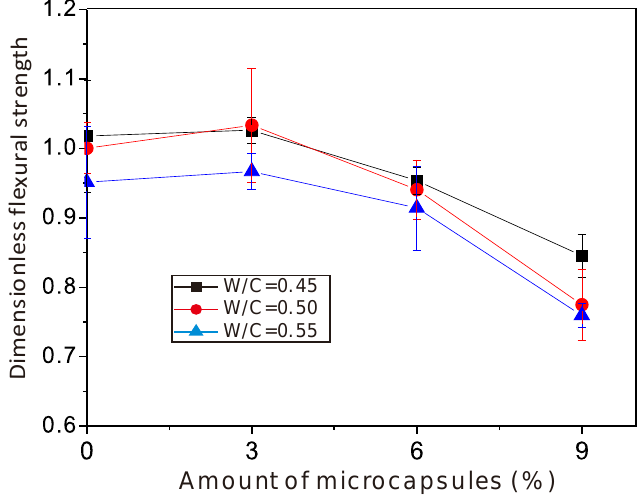
Figure 5. Variation of the flexural strength versus the amount of organic microcapsules.